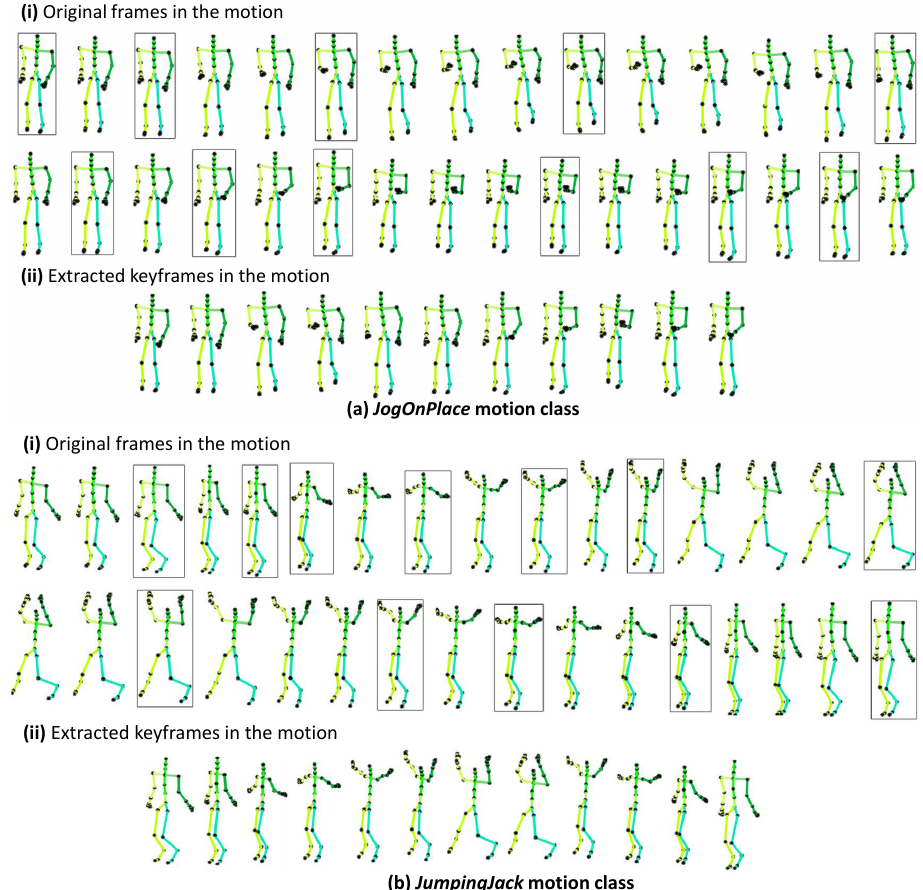
Figure 5. Qualitative results for our proposed keyframe extraction Algorithm 1 for the motion categories ( a ) jogOnPlace and ( b ) jumpingJack . The extracted keyframes are shown in boxes and also visualized separately to show a clear